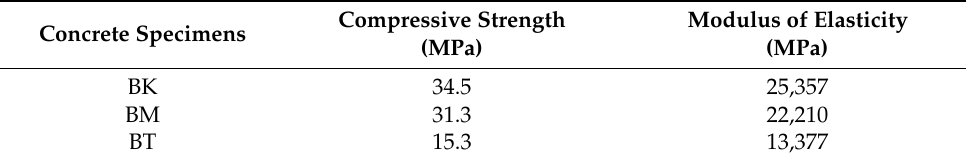
Figure 6. Development of shrinkage strains over 364 days.